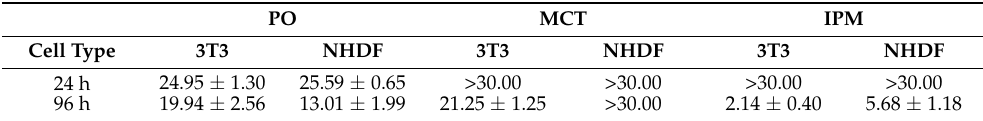
Table 5. The half-maximal inhibitory concentration ( IC 50 ) values of ISFO extracts expressed as the corresponding 12-HSA concentrations [%], calculated as arithmetic means ± SD of each triplicate measurement.